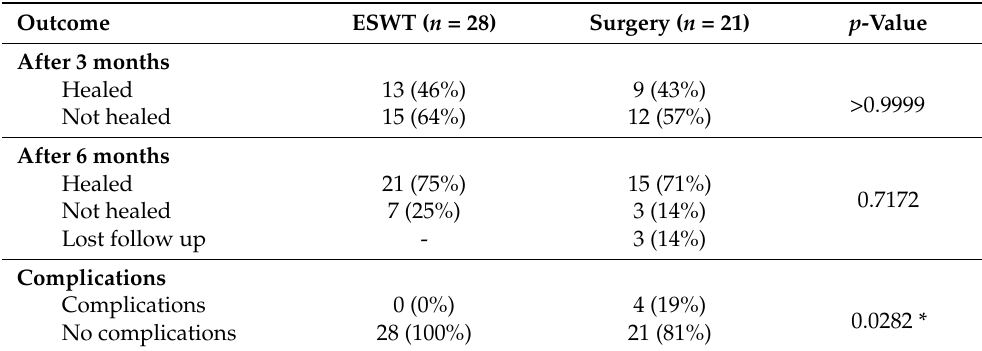
Table 2. Patient outcomes over time and statistical significance between the ESWT and Surgical groups are indicated by the p